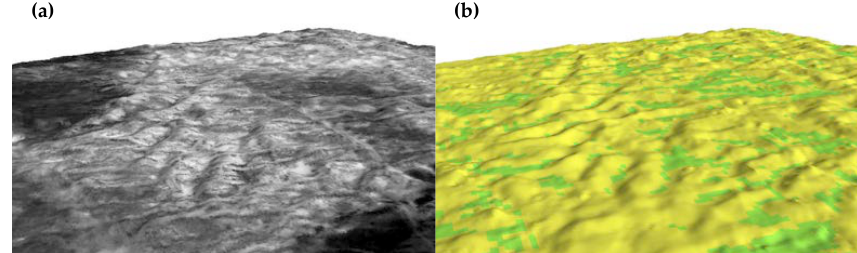
Figure 2. Subset bird’s-eye view images of the generated digital surface model (DSM) with ( a ) the summer PRISM data and ( b ) topography classification map (green is flat sandy lands; yellow is sand dunes). The height in images is exaggerated threefold to facilitate visualization.